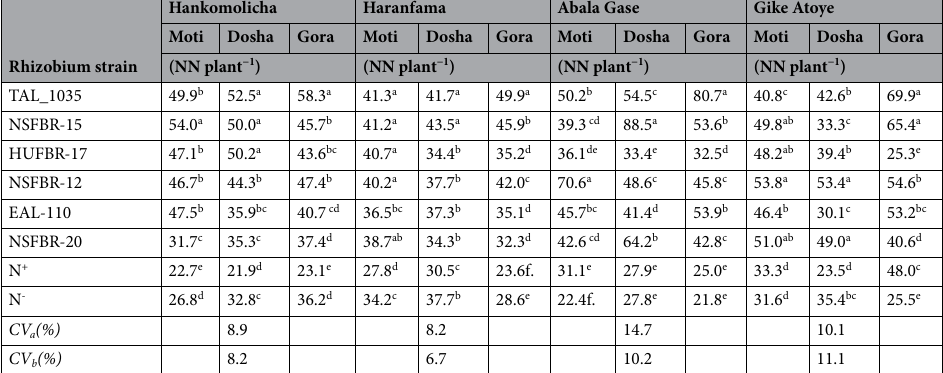
Table 4. Rhizobium strain × faba bean variety interaction effects on nodule number at the study locations. Mean values in the same column with different letter(s) are significantly different at p ≤ 0.05 probability level; NN Nodule numbers.